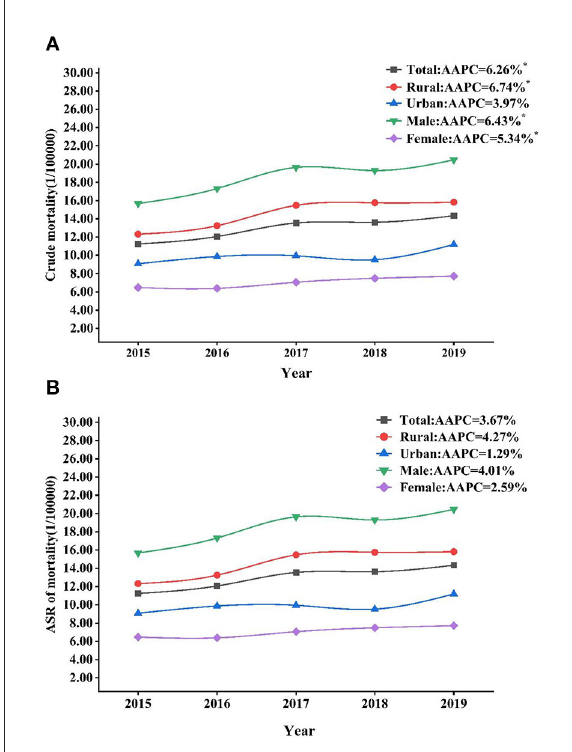
FIGURE1 Trends of crude mortality rates (A) and ASRs (B) of liver cancer in Yunnan by sex and region, 2015–2019. ASR, age standardized rate. * p < 0.05.